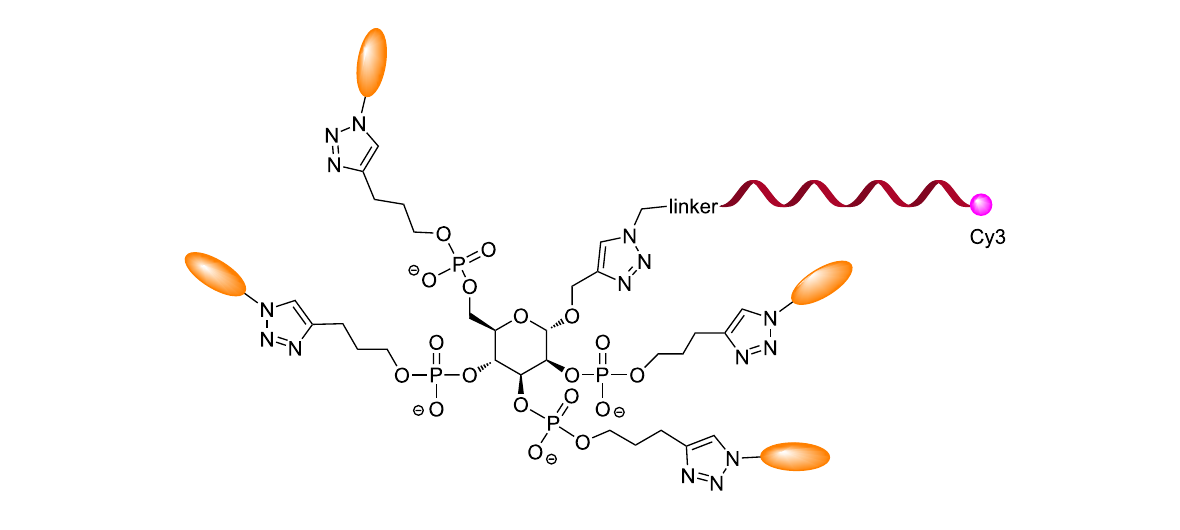
Figure 7: Multivalent sugar-core glycoconjugate DNA.